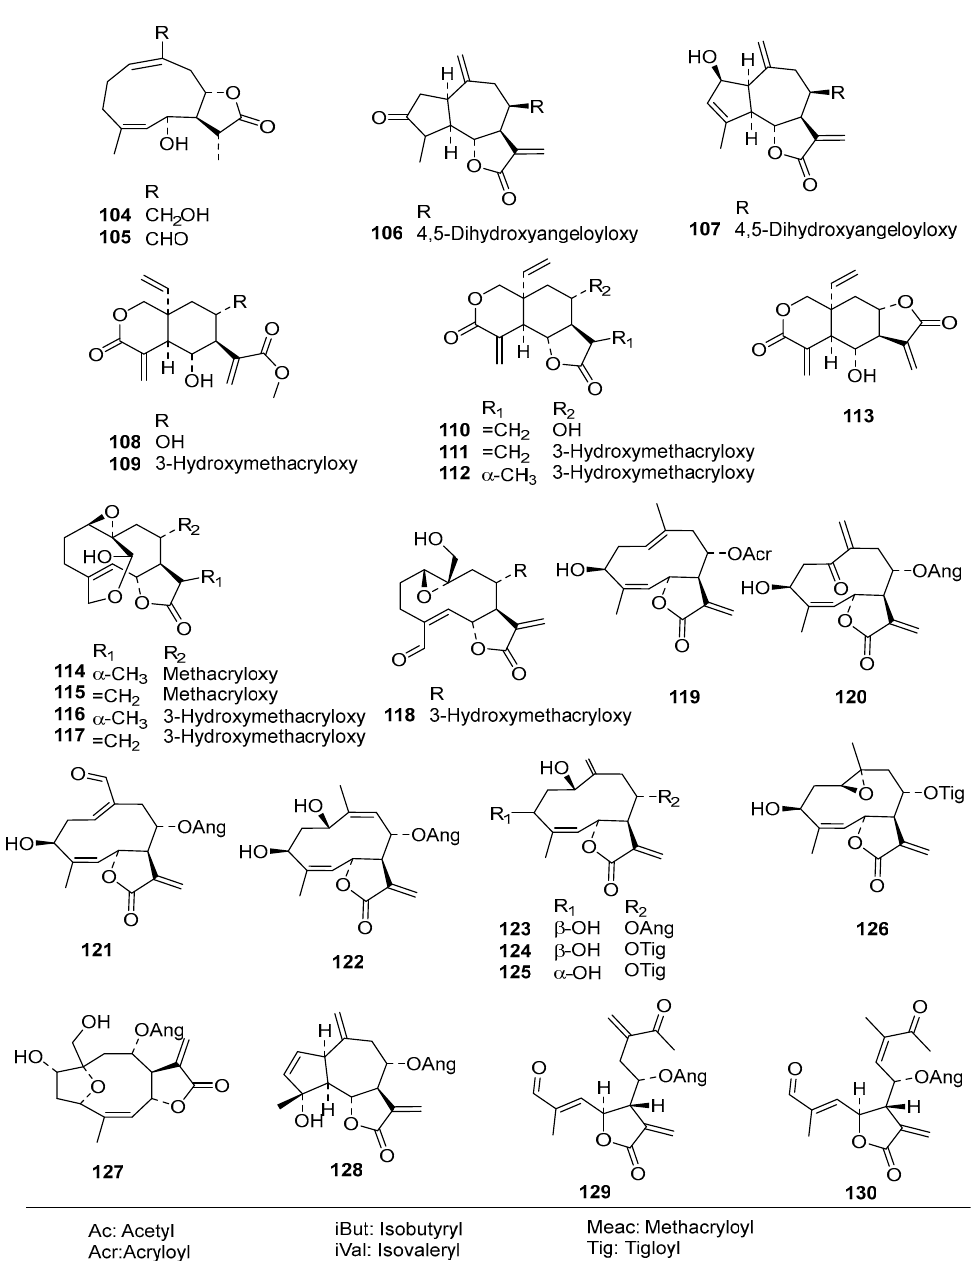
Figure 1. Cont. Structures of STLs used in the present QSAR analysis. Part 3 of the data set with compounds newly included in this QSAR study. 104 – 105 , 114 – 126 : germacranolides; 106 – 107 , 128 : guaianolides; 79 , 83 – 84 , 87 – 88 : eudesmanolides; 108 – 113 : elemanolides; 127 : furanoheliangolide; 129 – 130 : no subclass